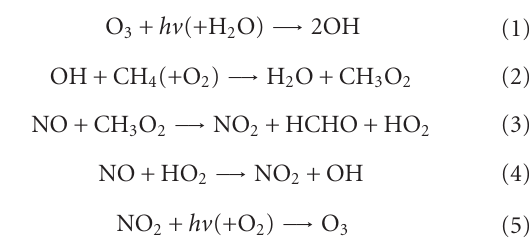
Europe, which then a ff ects the background in the Sahel and Sahara by advection inland. Increases due to road